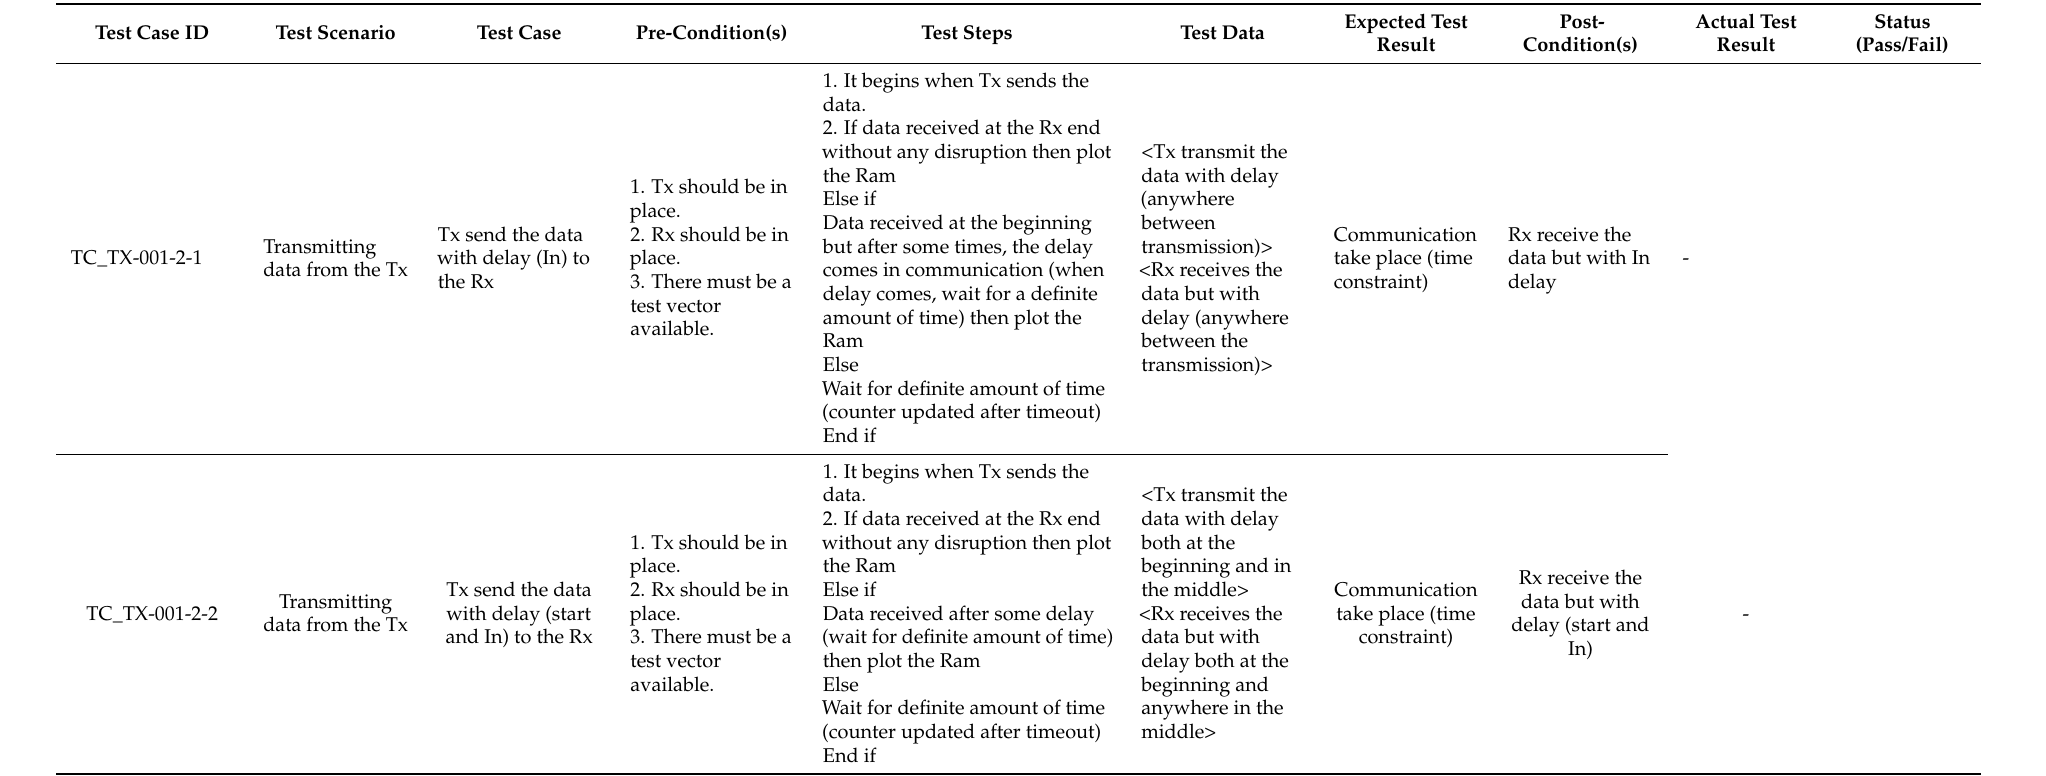
Table A2. Test Cases for